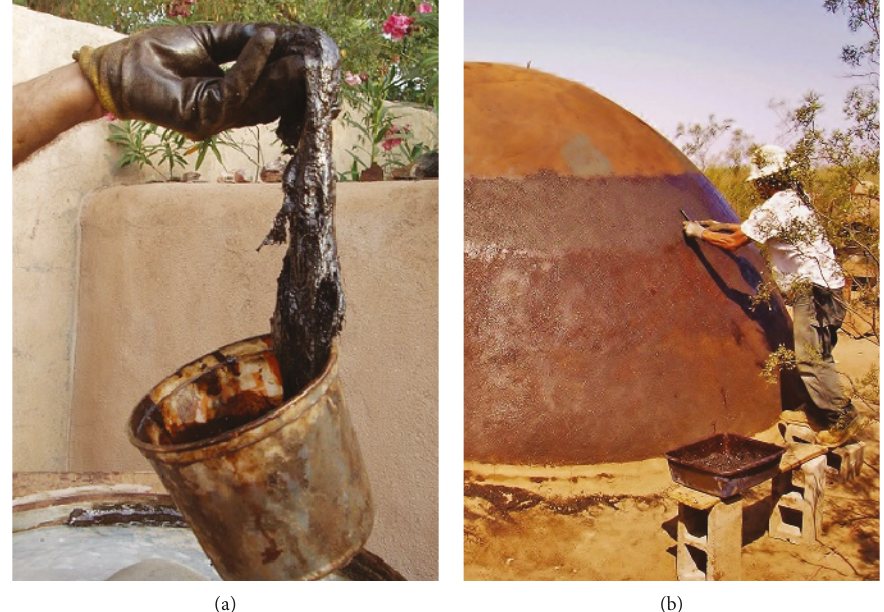
Figure 5: The fatty acid-based ionomer: (a) as removed from a bucket and (b) as applied onto an adobe structure that serves as an outer weather-resistant